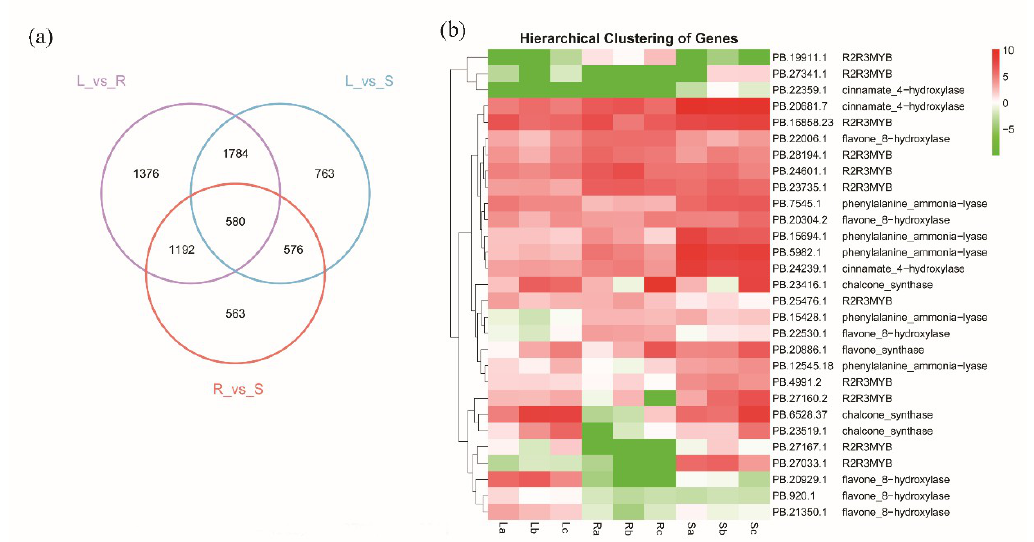
Table 2. Number of differentially expressed genes .